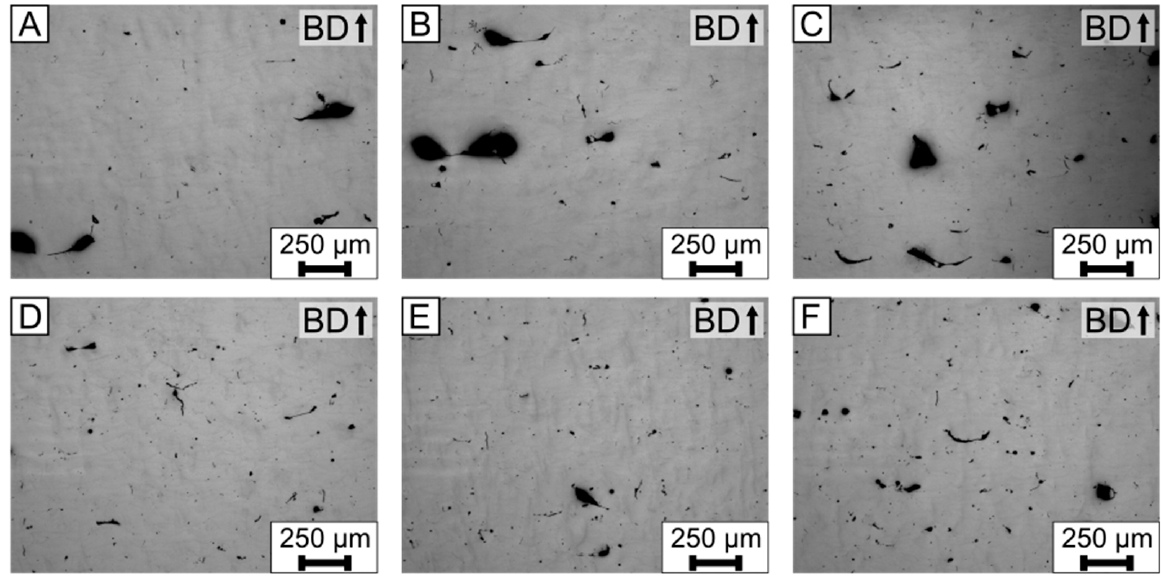
Figure 6. Light microscope images of the polished cross sections for the MOD2 +15 wt.% AlSi10Mg (Table 3). ( A – F ) Process parameters are listed in Table 2 and correspond to the letter of each cross section. Table 6 lists the results of the density measurements, which were calculated with image processing. Table 6. Results of the density measurements of Modification II specimens, done with image pro ‐ cessing. The process parameters used are listed in Table 2.